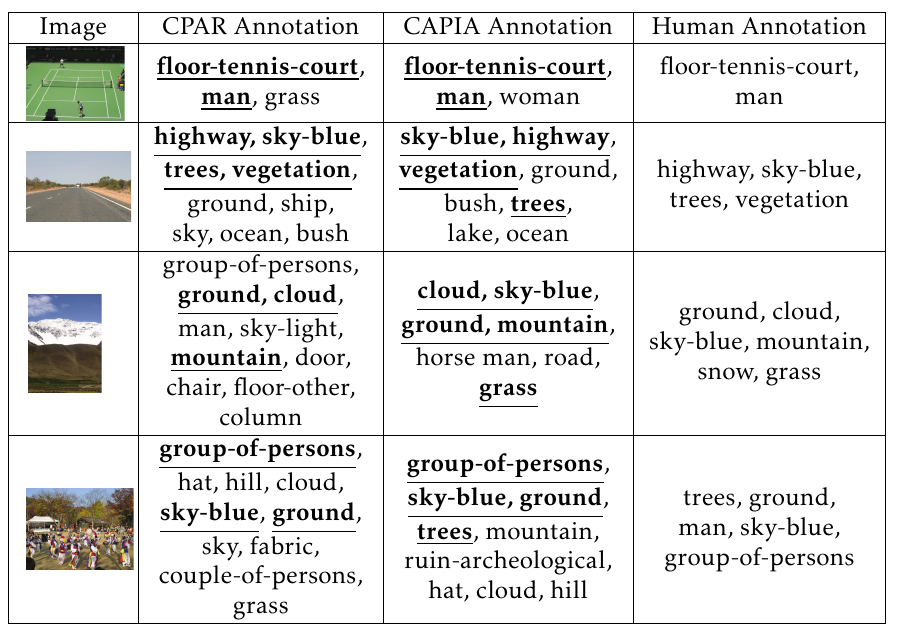
Table 1. Sample Annotation